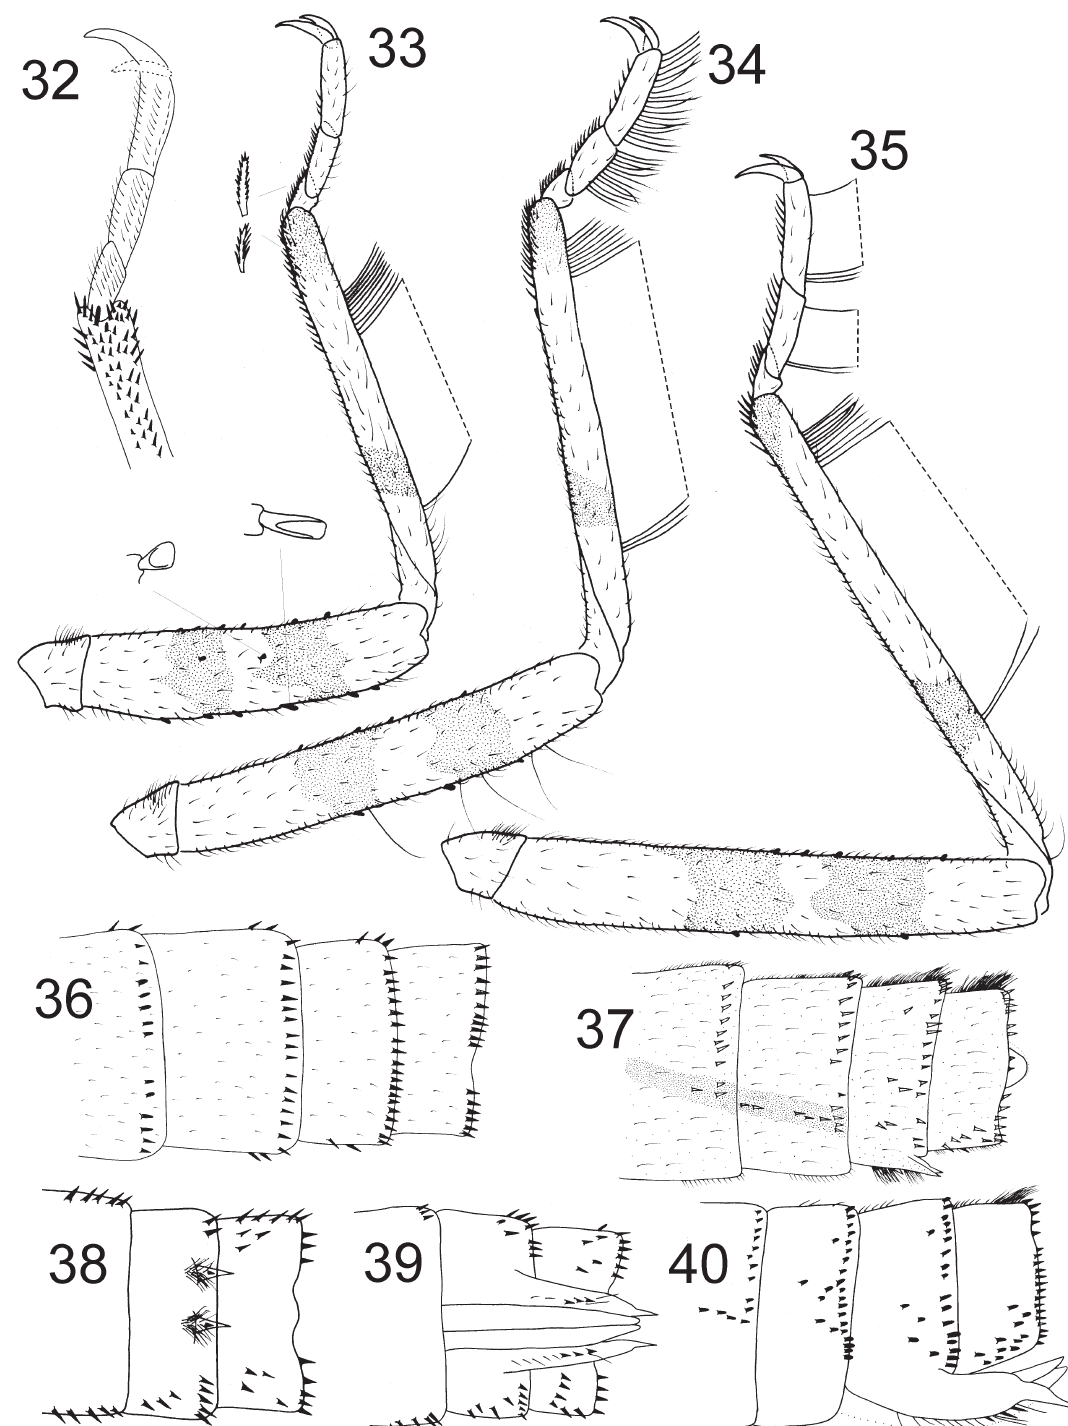
Figures 32-40 - Neoneura confundens , last instar larva: 32 , apex of fore tibia and tarsus, ventral view; 33 , fore leg, dorsal view; 34 , middle leg, dorsal view; 35 , hind leg, dorsal view (dotted lines indicate the row of long setae); 36 , male abdomen S7-10, dorsal view; 37 , male abdomen S7-10, lateral view; 38 , male S8-10, ventral view; 39 , female abdomen S8-10, ventral view; 40 , female abdomen S7-10, lateral